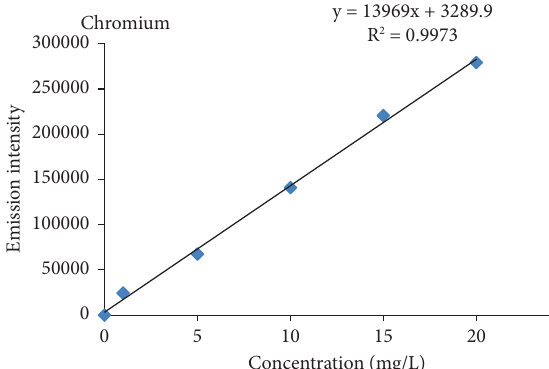
Figure 3: Standard calibration curve for chromium.